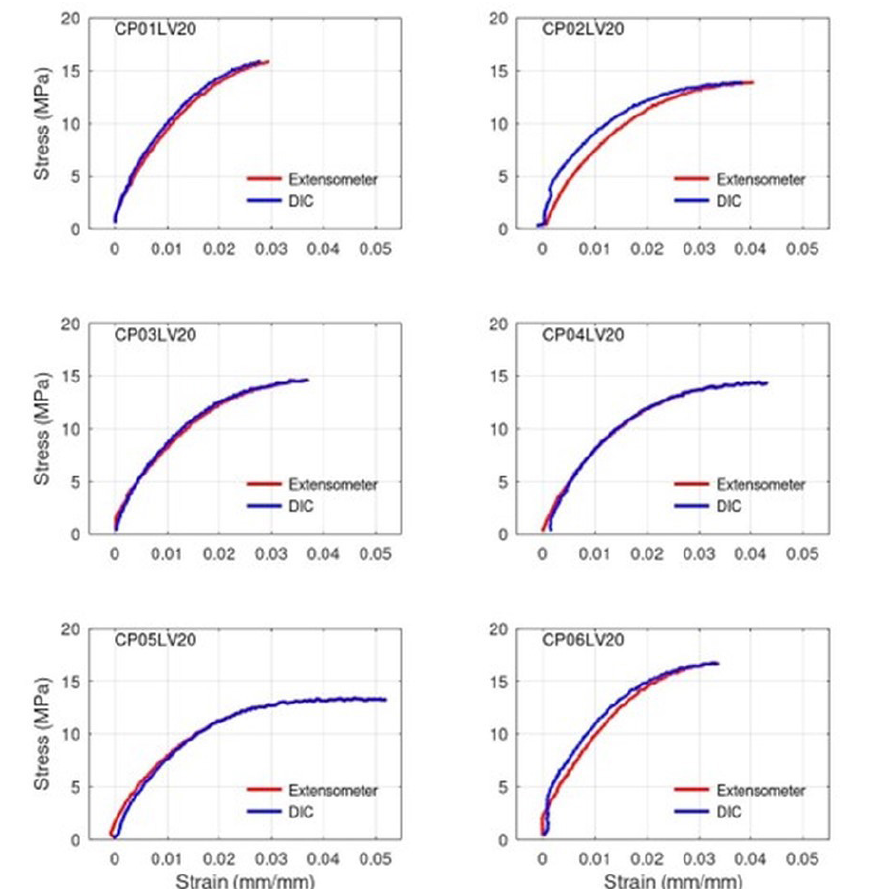
Figure 7. Stress x strain diagram of polyester matrix composites with 20wt% red mud with strains obtained via electrical strain gauge and via DIC.